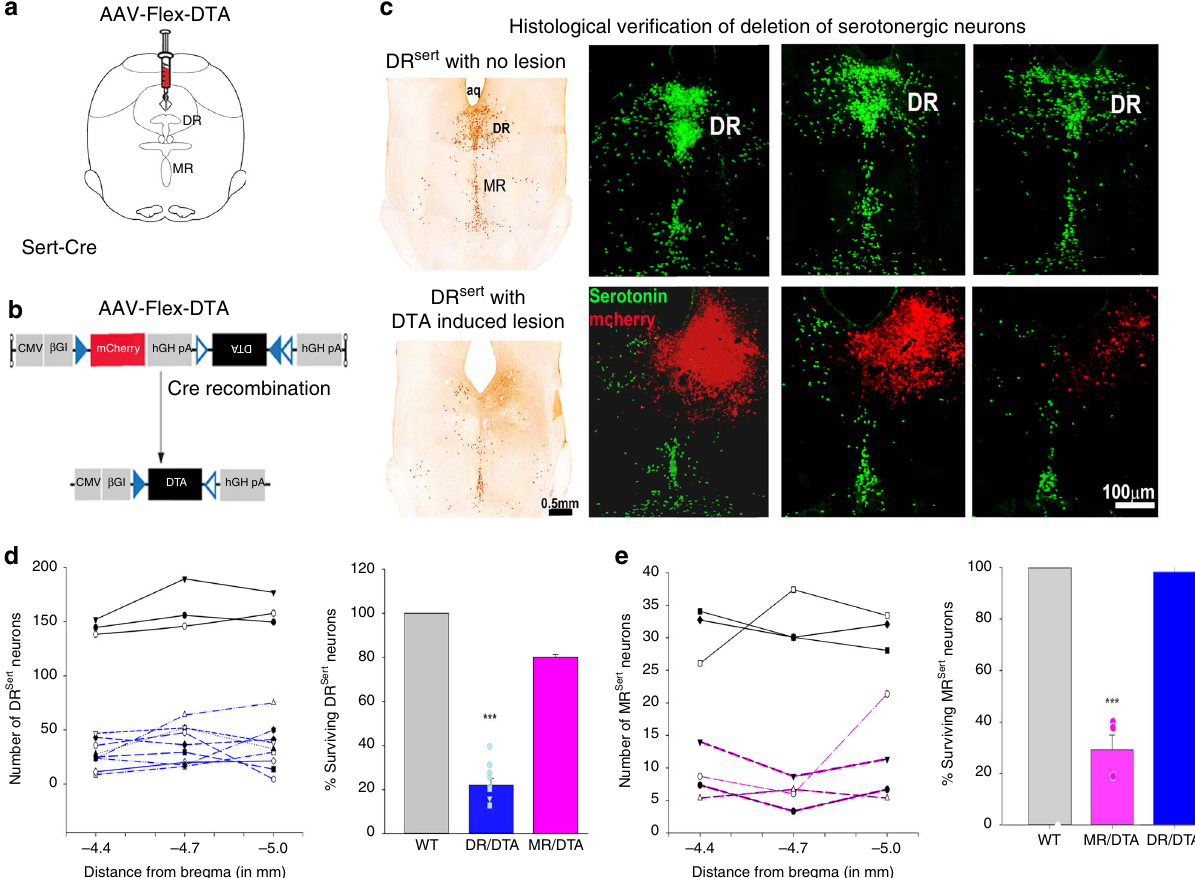
–4.4 –4.7 mm)–5.0 WT DR/DTA MR/DTA WT DR/DTAMR/DTA –4.4 –4.7 mm)–5.0 Distance from bregma (in Distance from bregma (in Fig. 1 AAV-Flex-DTA induced deletion of DR Sert neurons. The experimental strategy involved ( a ) injection of the viral vector that produced Cre- dependent expression of the diphtheria toxin A subunit ( b ) in the dorsal raphe of Sert-Cre-::L10 mice or wild-type littermates (WT). Injection of the vector deleted nearly all serotonergic neurons at the injection site in the Sert-Cre animals. This is seen in ( c ) the top row showing three levels from rostral-to caudal from an intact animal and the lower row from an animal that received an injection of the vector. Note that at low magni fi cation (left) with brown immunostaining for serotonin, that the DR contains almost no surviving neurons, while the MR is largely intact. At higher magni fi cation (right panels) fl uorescence images show the location of the injection site (marked by red stained intact non-serotonergic neurons) and that there are no surviving serotonin neurons within the boundaries of the red injection site. The loss of DR Sert and MR Sert neurons after DR injections sites ( d ), n = 9; DR-DTA, neuronal counts from each mouse is represented in left panel of d , with average percentage of neuronal survival on the right), where DR-DTA group ( n = 9); WT ( n = 3); MR-DTA ( n = 4) were signi fi cantly different (F 1,8 = 126.6; P < 0.001, One-way ANOVA with multiple comparisons). After MR injection sites ( e ), MR-DTA ( n = 4) is compared with intact WT animals ( n = 3) and DR-DTA ( n = 9), and these groups showed signi fi cant difference (F 1,5 = 86.5; P < 0.001, one-way ANOVA with multiple comparison). The error bars in d and e represent the standard error of mean (SEM). ***represents P < 0.001, one-way ANOVA to compare the groups in d and e . Cerebral aqueduct, aq; dorsal raphe, DR; median raphe, MR. Fig. 1a shows a drawing of the mouse brain at the level of the mid-DR (equivalent to plane − 4.6 mm from bregma, of the mouse brain atlas) 53